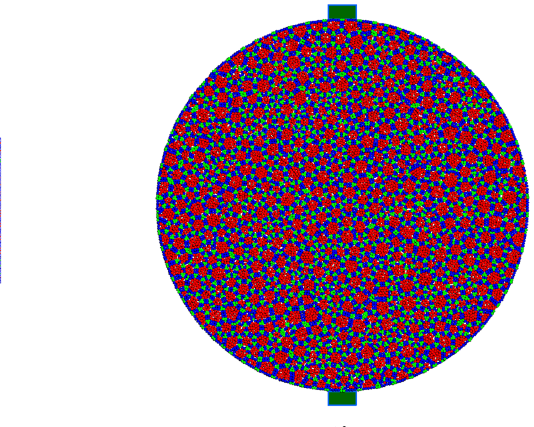
Figure 6. Rigid PM models boundary conditions through rigid plates: ( a ) rigid PM model; ( b ) grain deformability through inner discretization (Rigid PM-inner contacts).